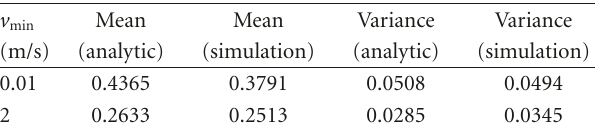
Table 1: Analytic and simulation results for mean and variance